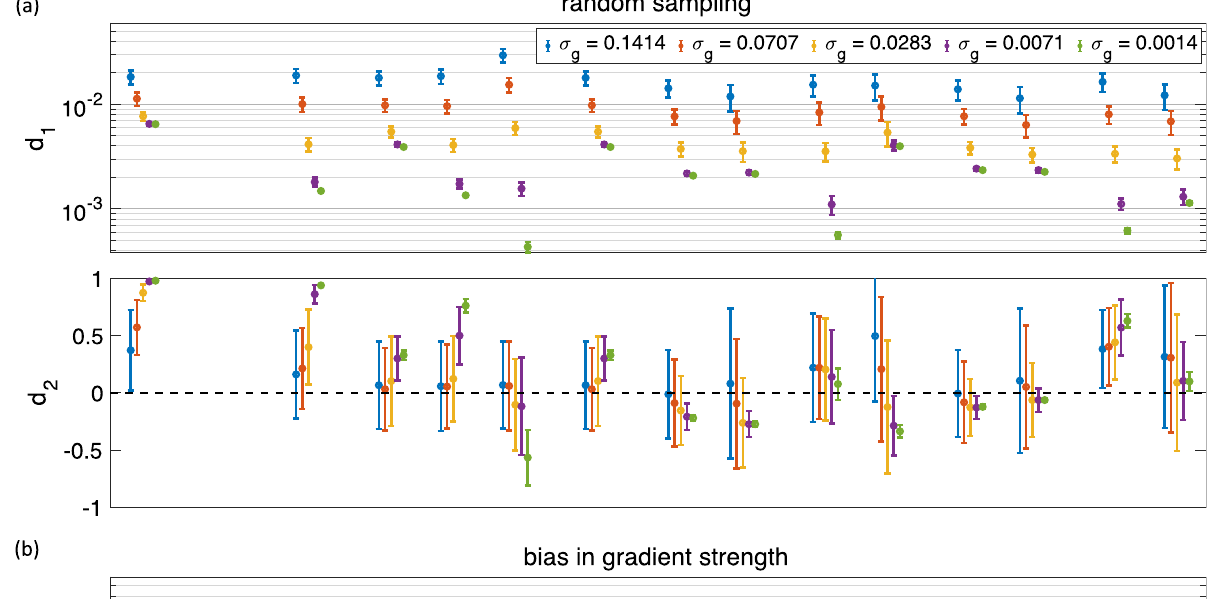
8) samples using different methods for ( a ) × 0.1414, 0.0707, 0.0283, 0.0071, 0.0014 =